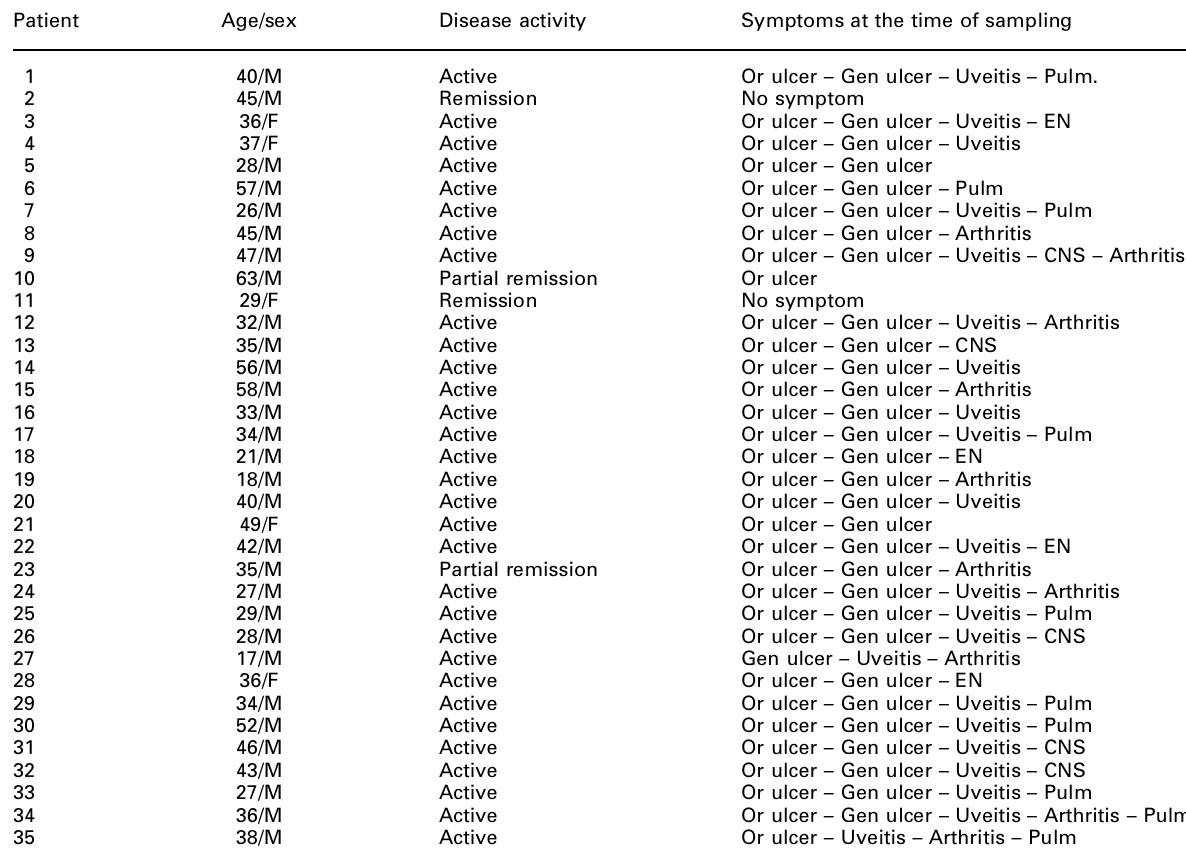
Table 1. Clinical features of patients with Behçet’s disease